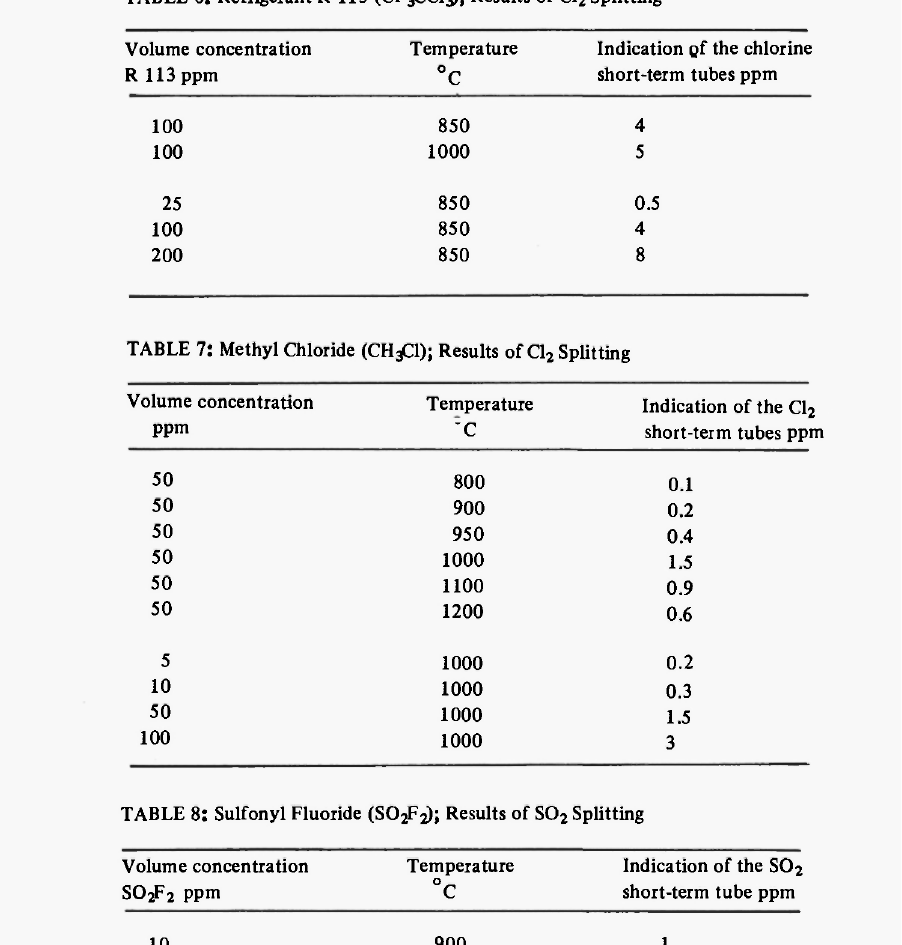
TABLE 6: Refrigerant R 113 (CF3CCI3); Results of Cl 2 Splitting